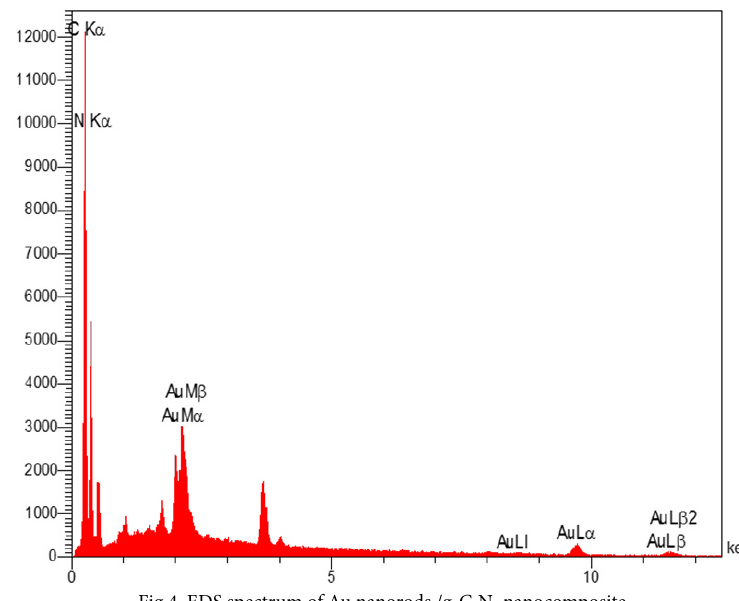
Fig.4- EDS spectrum of Au nanorods /g-C 3 N 4 nanocomposite